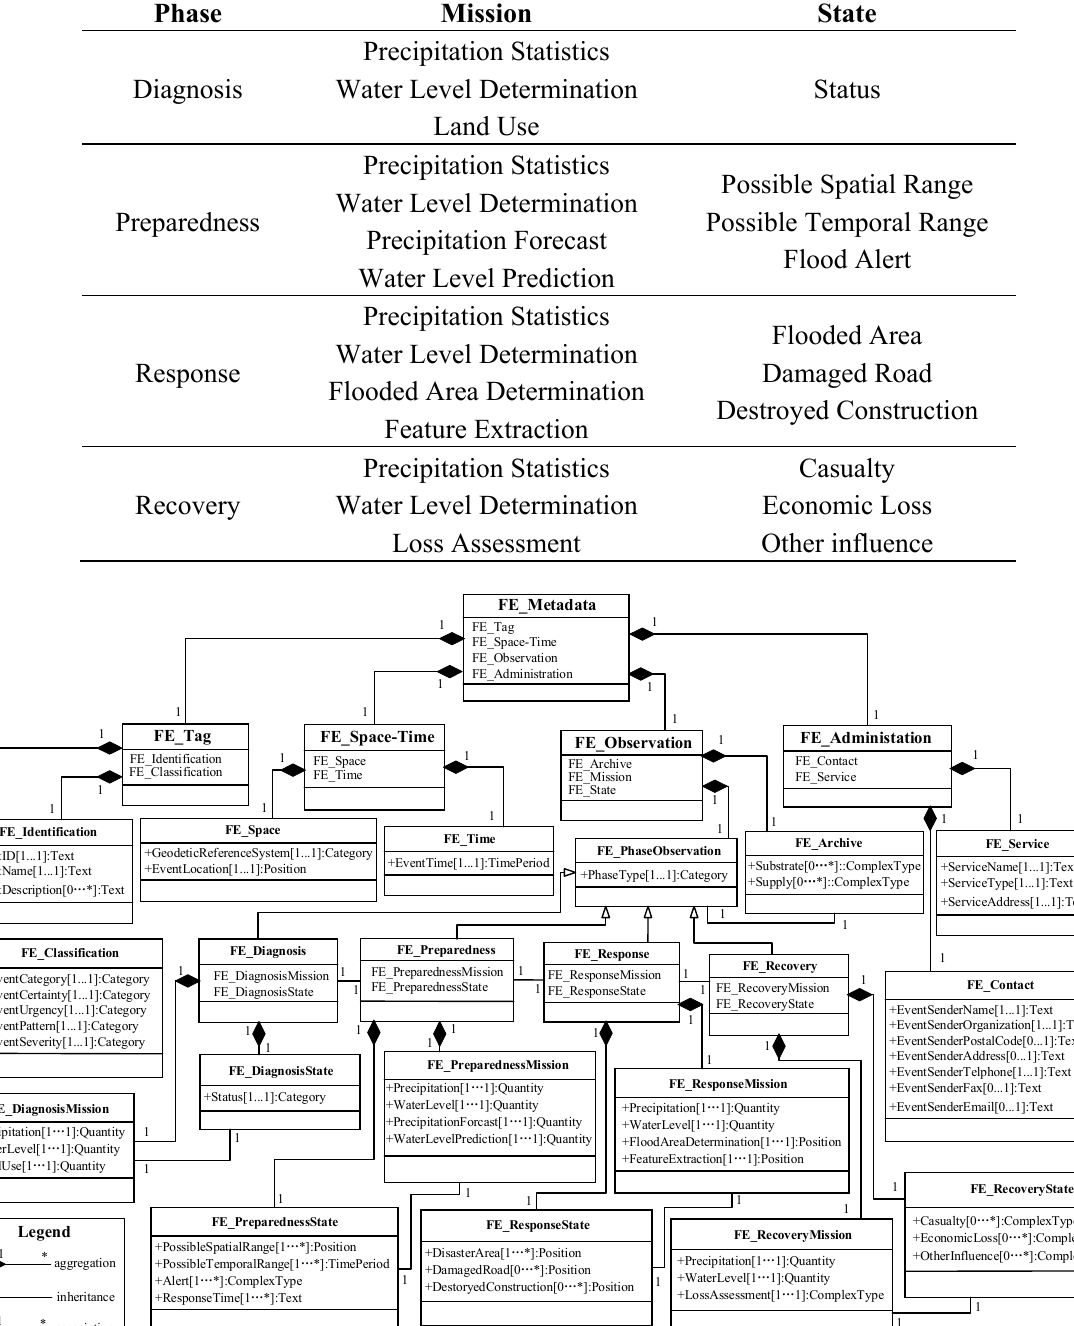
Table 1. Missions and states in different flood event phases.